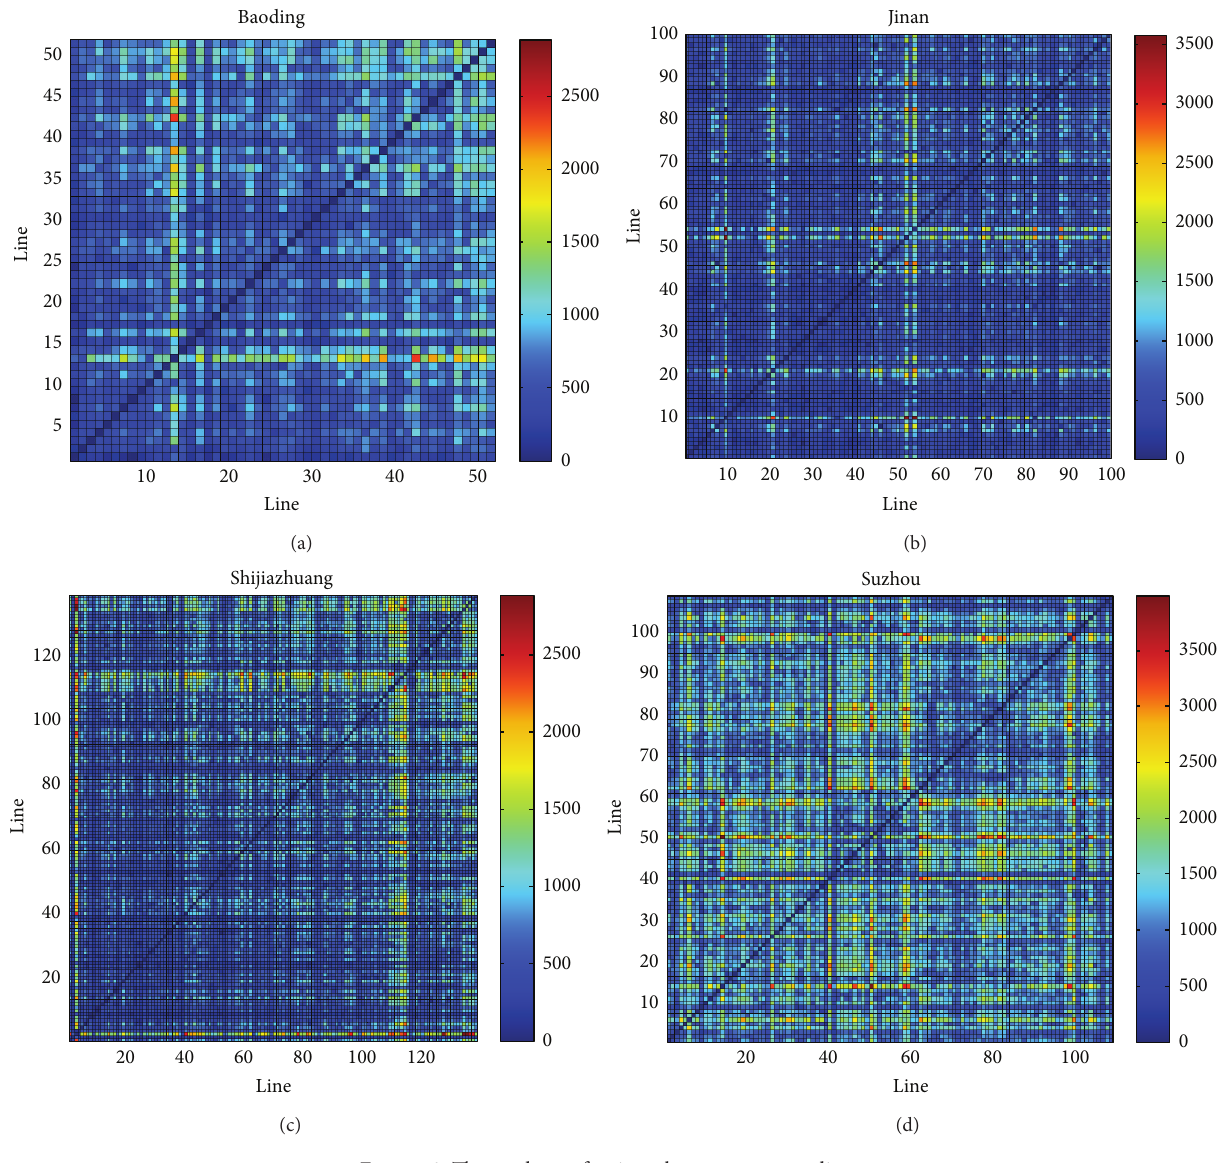
Figure 3: The total transfer times between any two